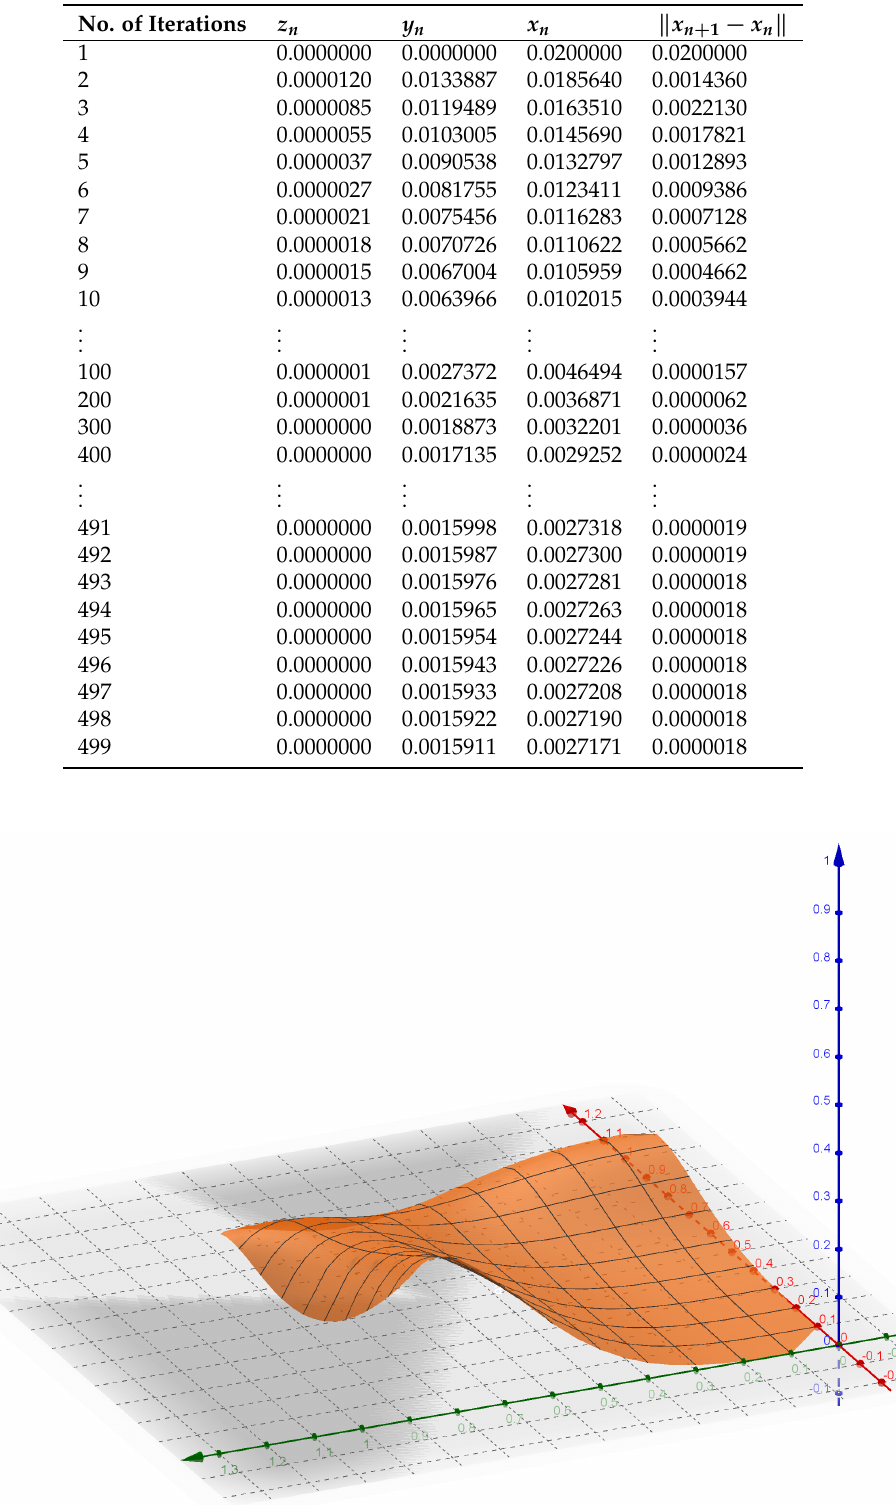
Figure 1. Plotting of g ( x , y ) for all x , y ∈ [ 0,0.9 ] and α =